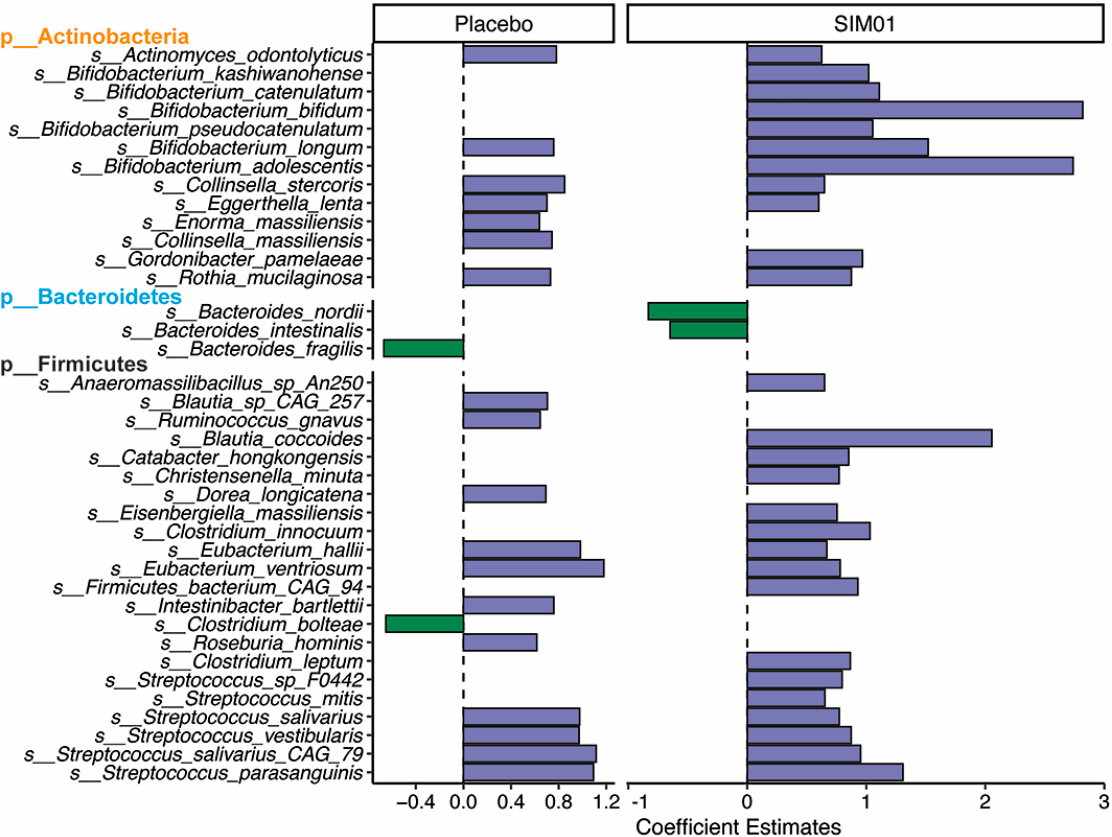
Figure 4. Differential species between baseline and 3 months after the second dose of vaccination for placebo (n = 123) and SIM01 (n = 135). Differentially abundant species were detected using Maasline2 considering the subjects as random effects ( p value < 0.05, FDR corrected p < 0.25). Purple colour, species enriched during 3 months after the second dose of vaccination versus the baseline; green colour, species depleted during 3 months after the second dose of vaccination versus the baseline.